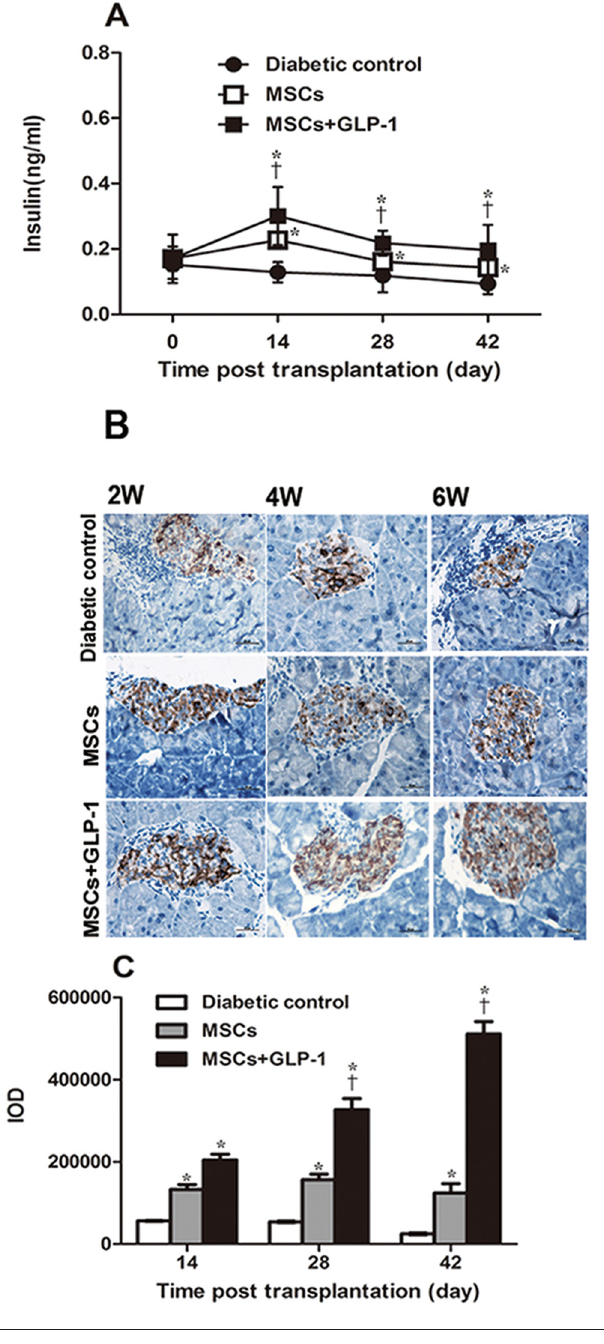
Figure 3. GLP-1 enhances the effect of MSCs on preserving islet β cell function in NOD mice. Following treatment with MSCs and GLP-1 or MSCs alone, the levels of fasting insulin in individual mice at the indicated time points post treatment were measured and the content of insulin in the pancreatic islets was determined by immunohistochemistry. Data are representative images (magnification × 400) or expressed as the mean ± SEM of each group of mice (n = 6 per group per time point) from three separate experiments. (A) Fasting plasma insulin levels. (B) Immunohistochemistry analysis of insulin content in the pancreatic islets. (C) Quantitative analysis of insulin levels. * P < 0.05 versus diabetic controls. † P < 0.05 versus mice treated with MSCs